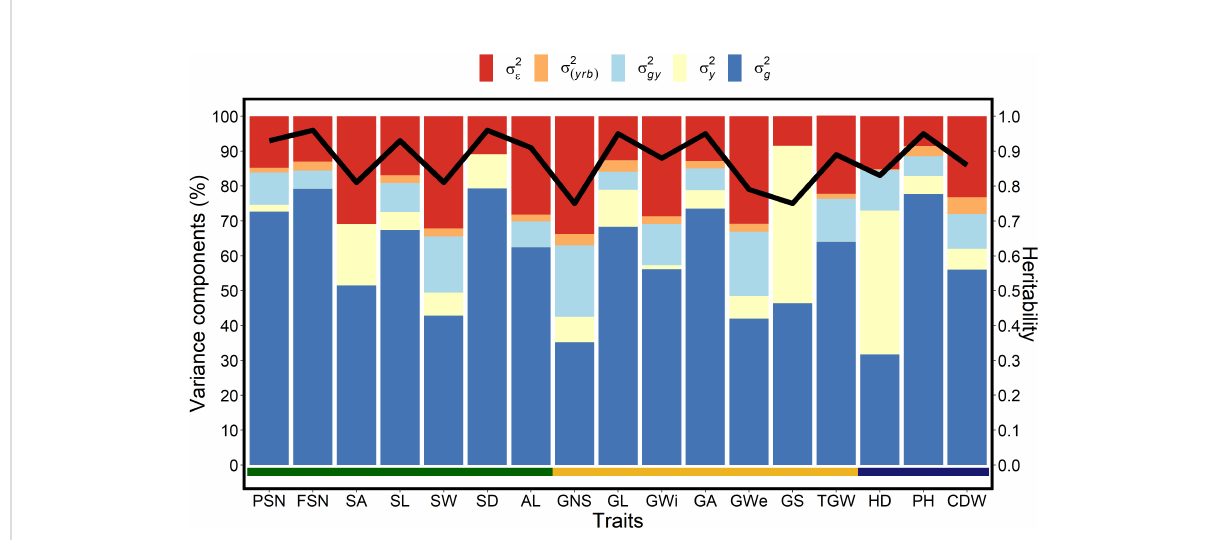
FIGURE 1 Proportion of the different variance components and heritability for each investigated trait in a panel of 417 six-rowed spring barley accessions. The x -axis represents all investigated traits, the left y -axis denotes the proportion of the variance components in percent, and the right y -axis represents the heritability scores. The black line represents the heritability value for the respective trait, s 2 g is the genotypic variance, s 2 y is the year variance, s 2 g y is the (genotype × year) interaction variance, s 2 ( yrb ) is the year and replication variance with replication nested into the blocks and s 2 ϵ is the error or residual variance. The spike traits indicated by the green horizontal line includes potential spikelet number (PSN), fi nal spikelet number (FSN), spikelet abortion (SA in %), spike length (SL in cm), spike weight (SW in g), spike density (SD) and awn length (AL). Grain traits represented by the yellow horizontal line includes grain number per spike (GNS), grain length (GL in mm), grain width (GWi in mm), grain area (GA in mm 2 ), grain weight per spike (GWe in g), grain set (GS in %), thousand-grain weight (TGW in g) and the shoot traits represented by blue horizontal line includes heading date (HD in days from January 1 st ), plant height (PH in cm) and culm dry weight (CDW in